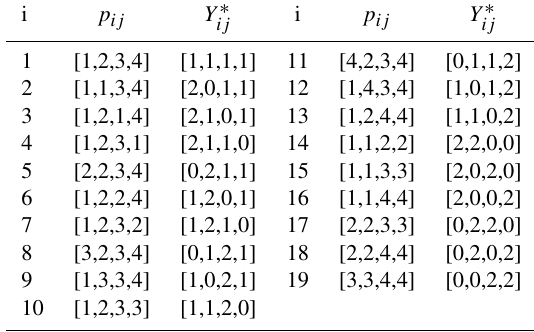
Table 1. In this table, p ij is a pointer vector selecting data from a particular set of spectral density values. For exam- ple p 4 j = [ 1 , 2 , 3 , 1 ] ; applying this pointer to the set of J (0) values would select the J (0) values obtained at 600 ( × 2), 700, and 800 MHz. The corresponding counter vector Y ∗ [ 2 , 1 , 1 , 0 ] is the numbers of times J (0) values recorded at the different fields were sampled. The process would be repeated i = 1260th bootstrap sample uses p 4 j to select J (0), p 10 j to